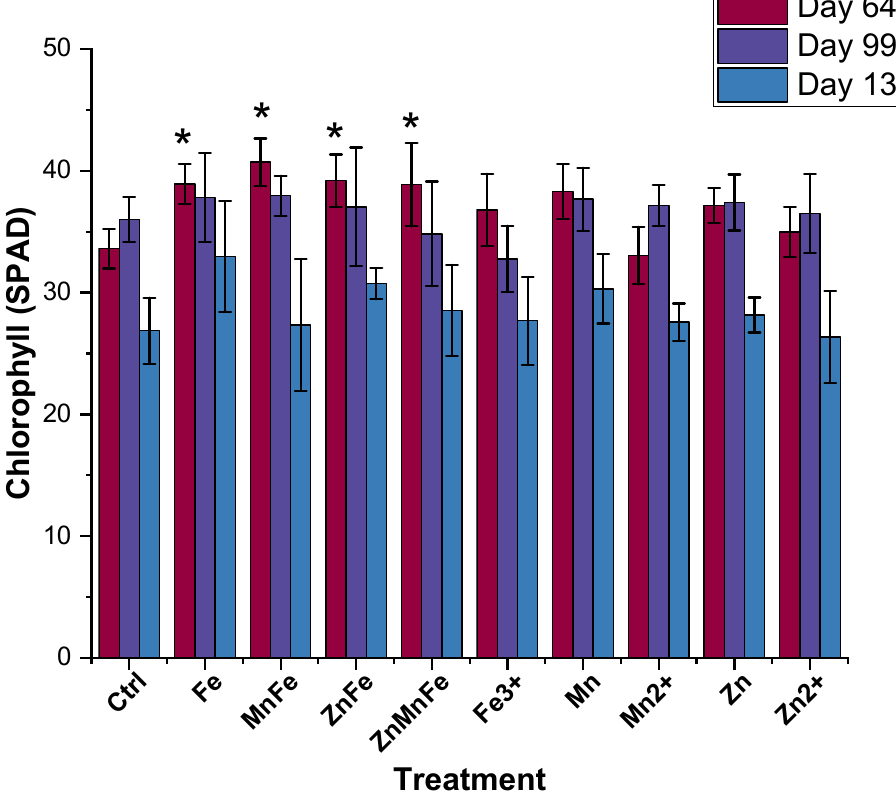
Figure 5. Chlorophyll content of tomato plant leaves after exposure to either Fe 3 O 4 (Fe), MnFe 2 O 4 (MnFe), ZnFe 2 O 4 (ZnFe), Zn 0.5 Mn 0.5 Fe 2 O 4 (ZnMnFe), Mn 3 O 4 (Mn), ZnO (Zn), or their ionic counterparts at 64, 99, and 135 days of growth; n = 4; * denotes statistical difference between control and treatments.